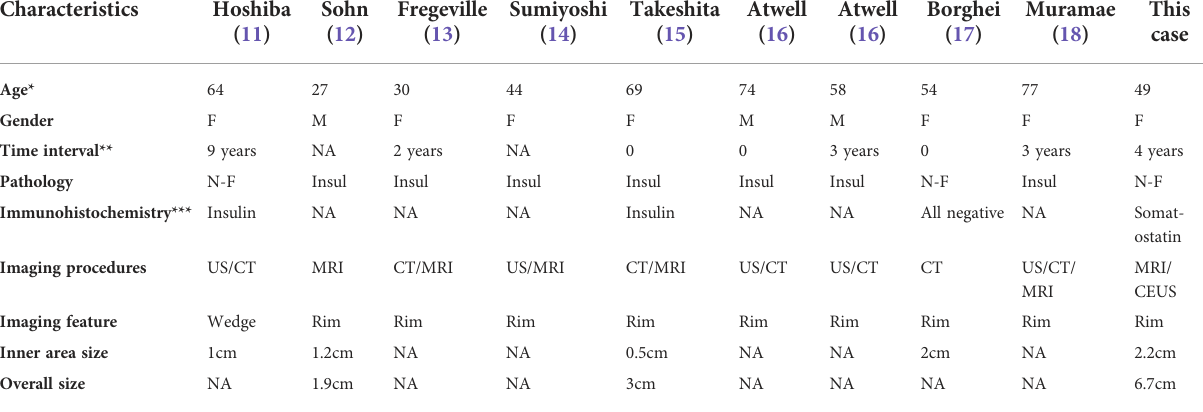
TABLE 1 Brief review of metastatic NEN cases with peritumoral liver steatosis in the literature and this